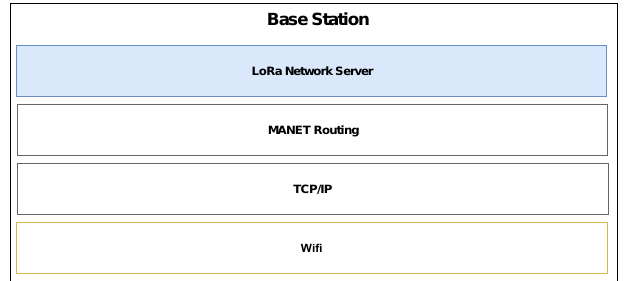
Figure 4. System stack of base station